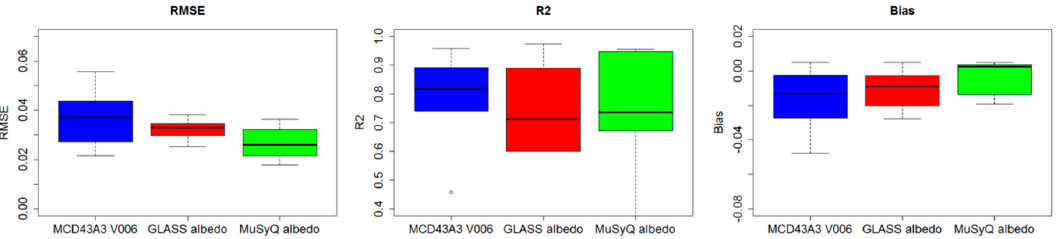
Figure 9. Box plots of the RMSEs ( left ), R 2 ( middle ), and Biases ( right ) from the multi-scale validation throughout the sites with large representativeness throughout the sites with large representativeness errors.